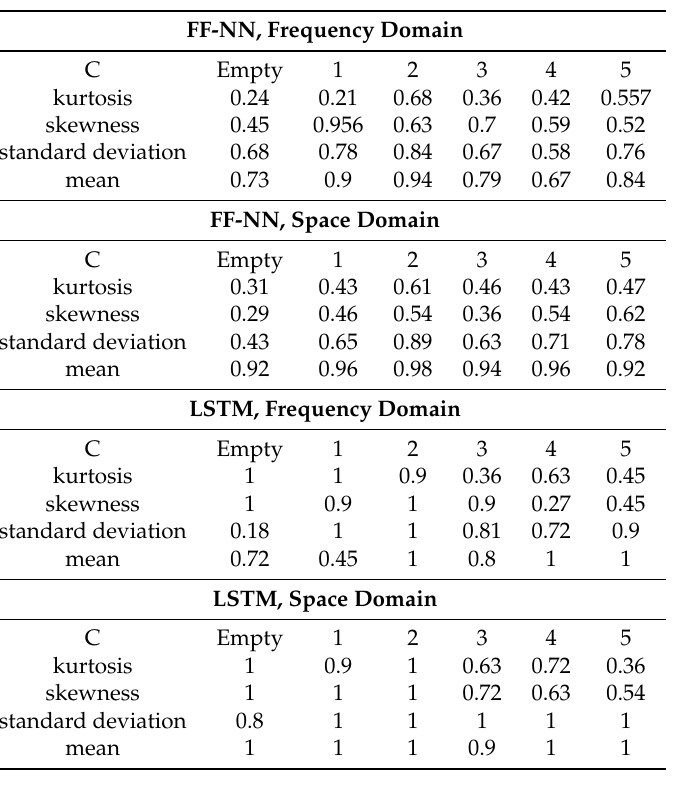
Table 3. Accuracy of counting subjects using machine learning tools in space and frequency